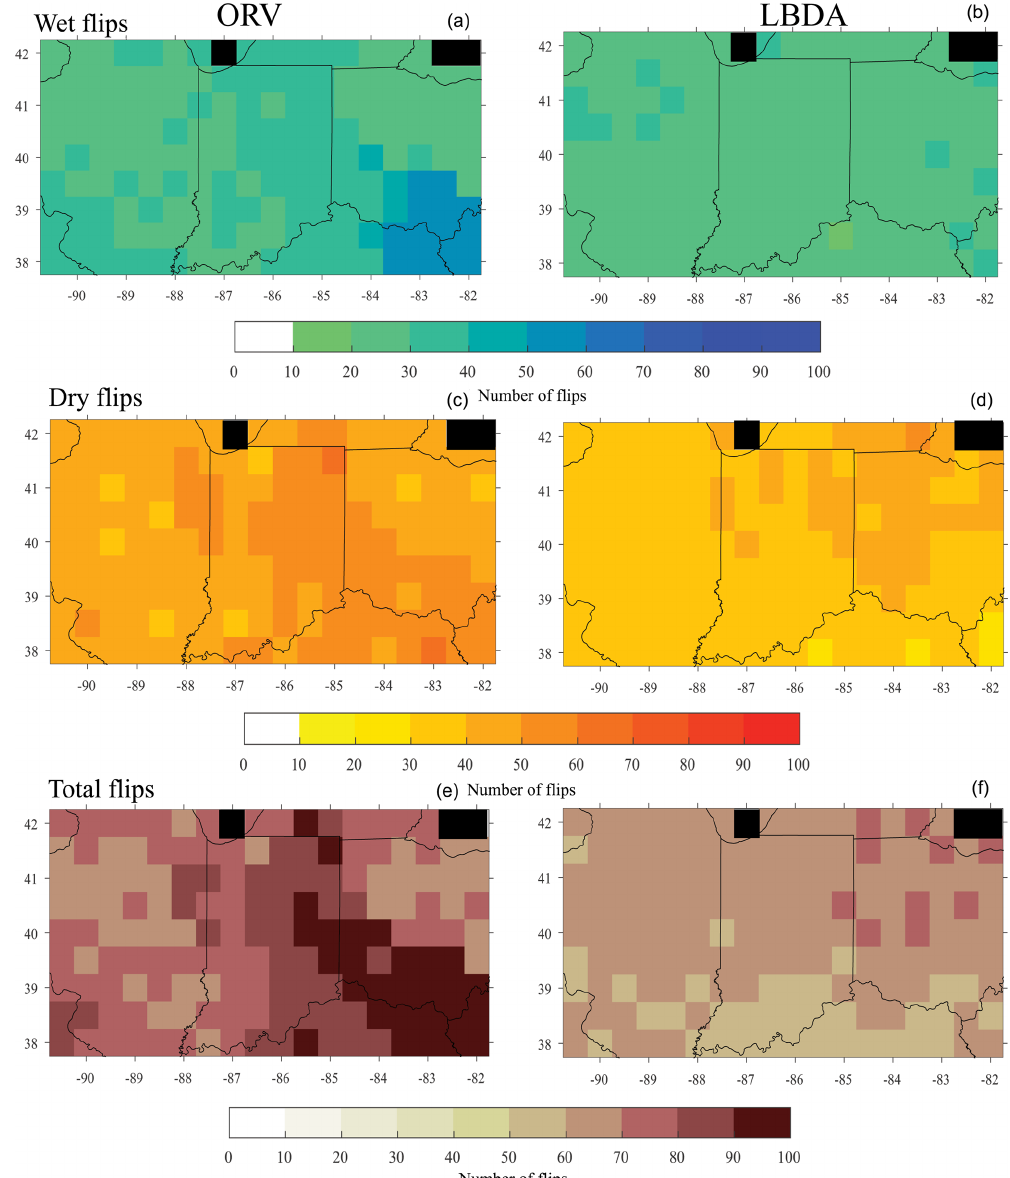
Figure 7. Maps of the number of wet flips (a, b) , dry flips (c, d) , and total flips (e, f) , for the ORV (a, c, e) and the LBDA (b, d, f) . Black cells represent values over water and therefore no